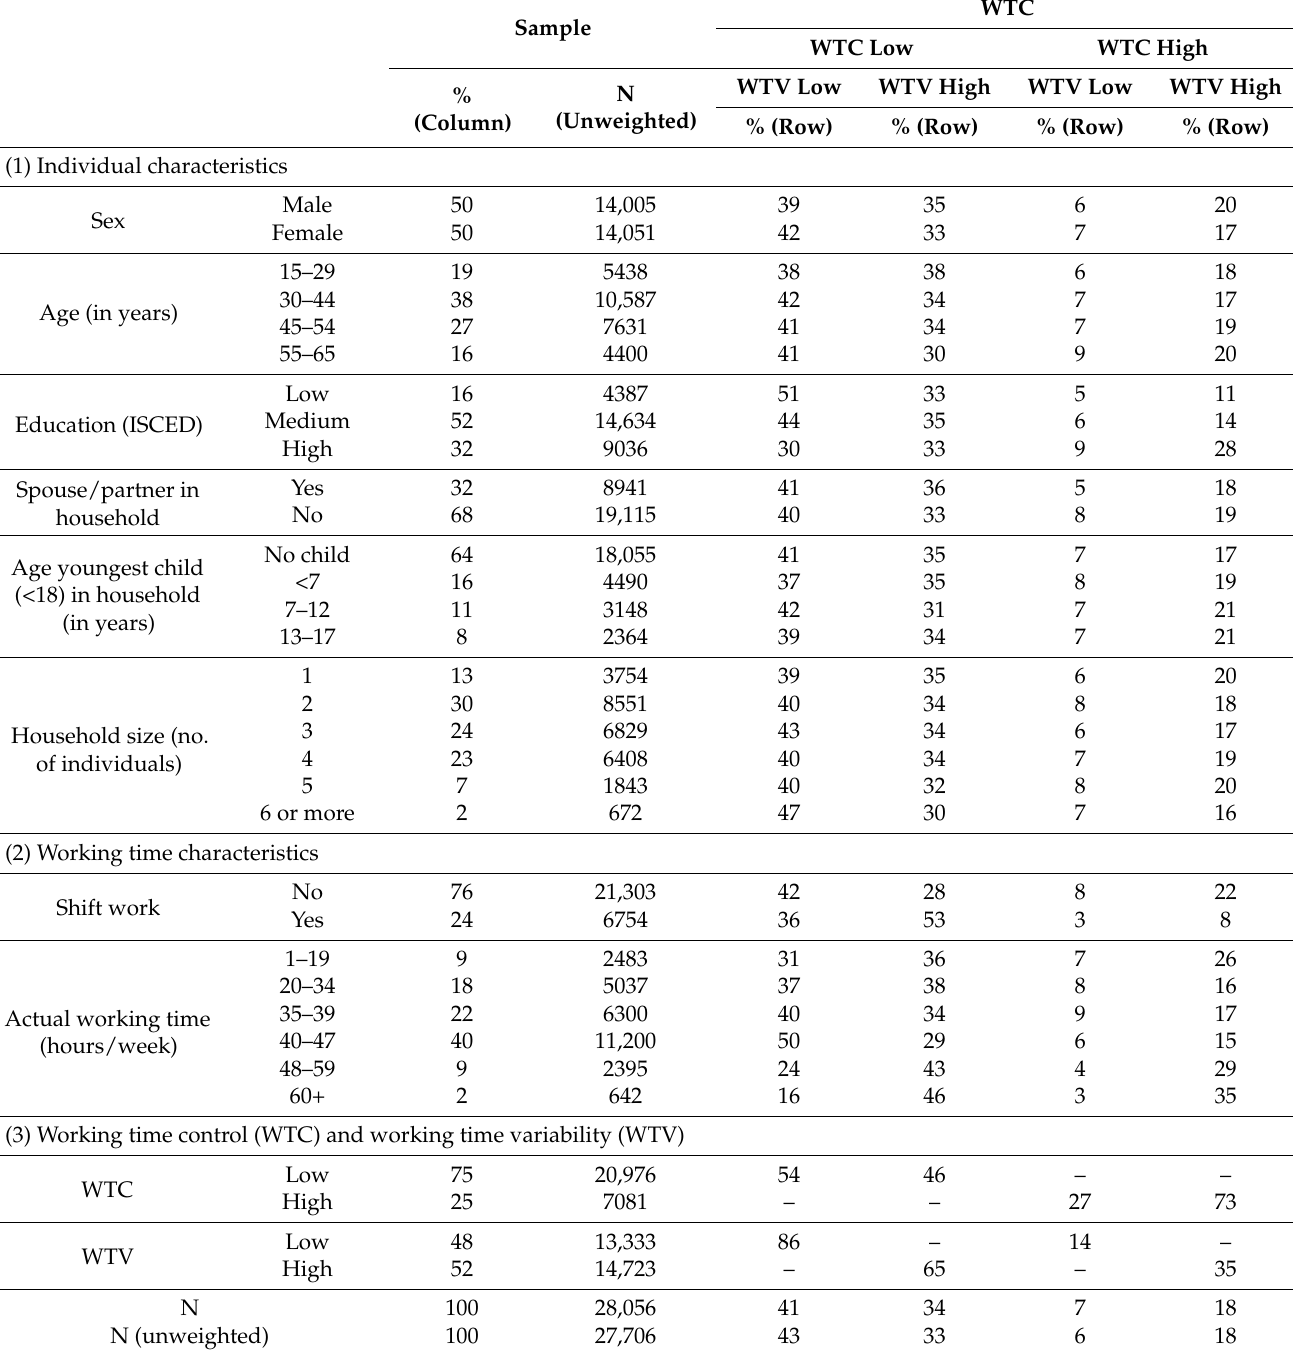
Table 1. Descriptive sample statistics (weighted by cross-national weights for the EU28, unless